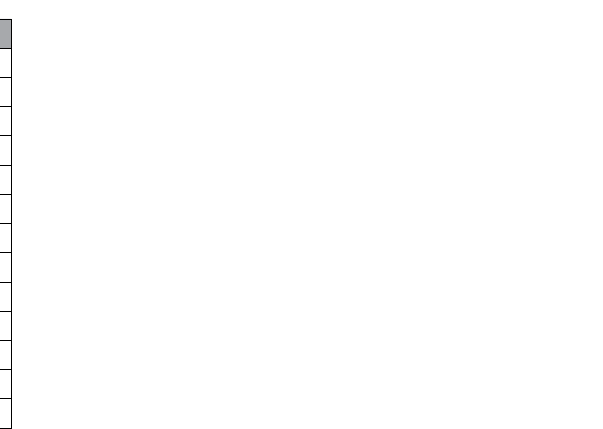
Figure 2. OPLS-DA applied to NMR and MS data obtained by the analysis of olive leaves (Xf+: samples from X. fastidiosa inoculated plants; Xf−: samples from X. fastidiosa non-inoculated plants). ( a ) OPLS-DA applied to NMR data: t(1)/t O (1) score plot relating to P1/O1; ( b ) OPLS-DA applied to MS data: t(1)/t O (1) score plot relating to P1/O1.